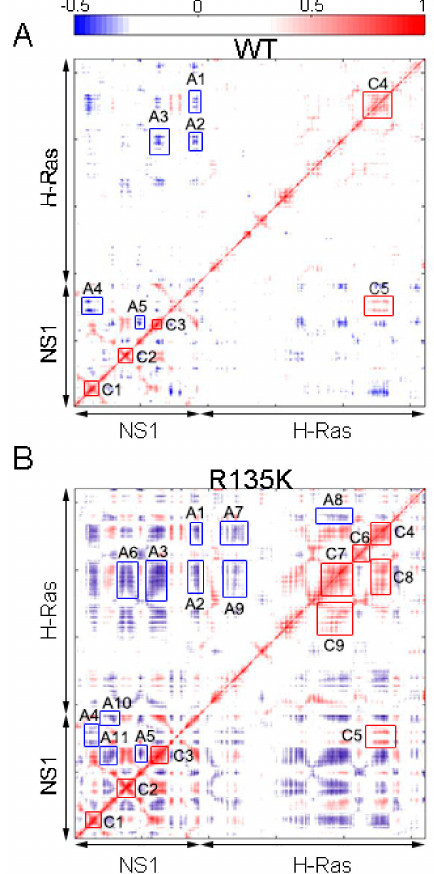
Figure 2. Dynamic cross-correlation matrices of wild type complex ( A ) and R135K ( B ) H-Ras–NS1 complex. Red stands for correlation and blue stands for anticorrelation. Correlated motions whose absolute values were smaller than 0.3 were